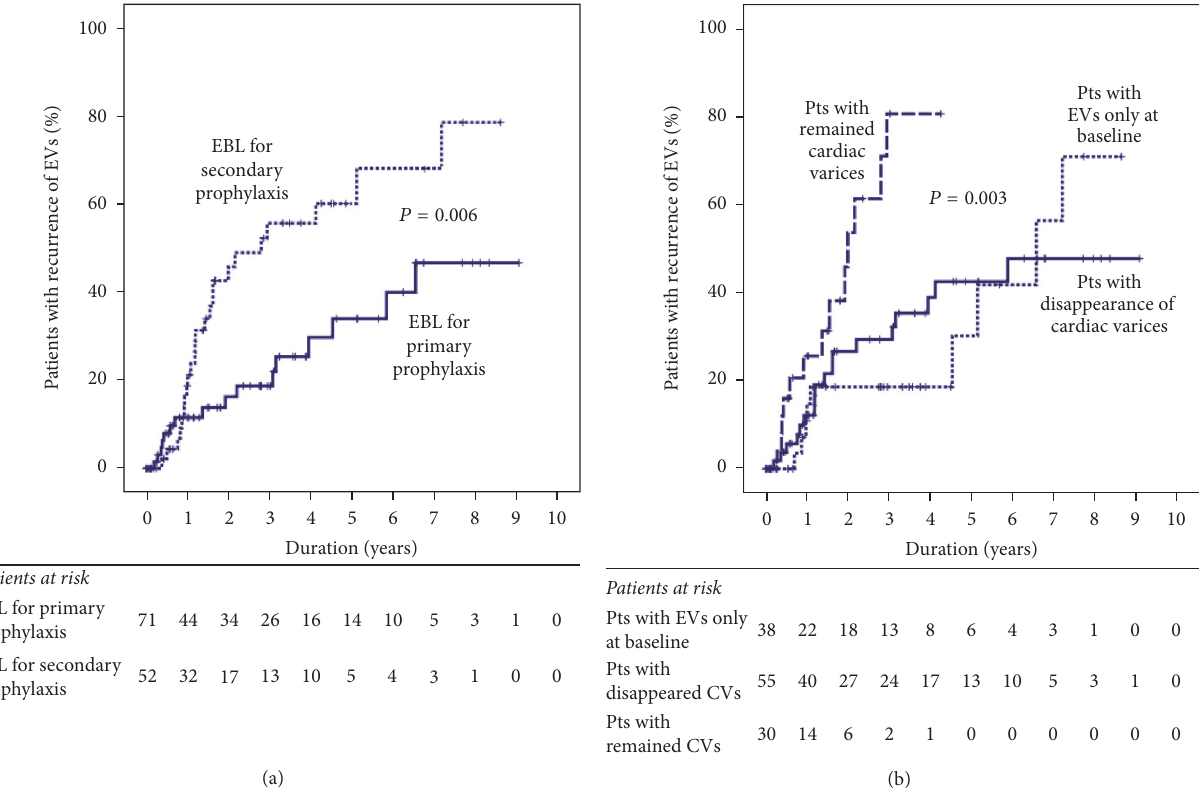
Figure 3: Cumulative incidence of recurrence for esophageal varices after eradication by endoscopic band ligation according to (a) the purpose of endoscopic band ligation and (b) the changes in cardiac varices after eradication of esophageal varices. EBL: endoscopic band ligation; EV: esophageal